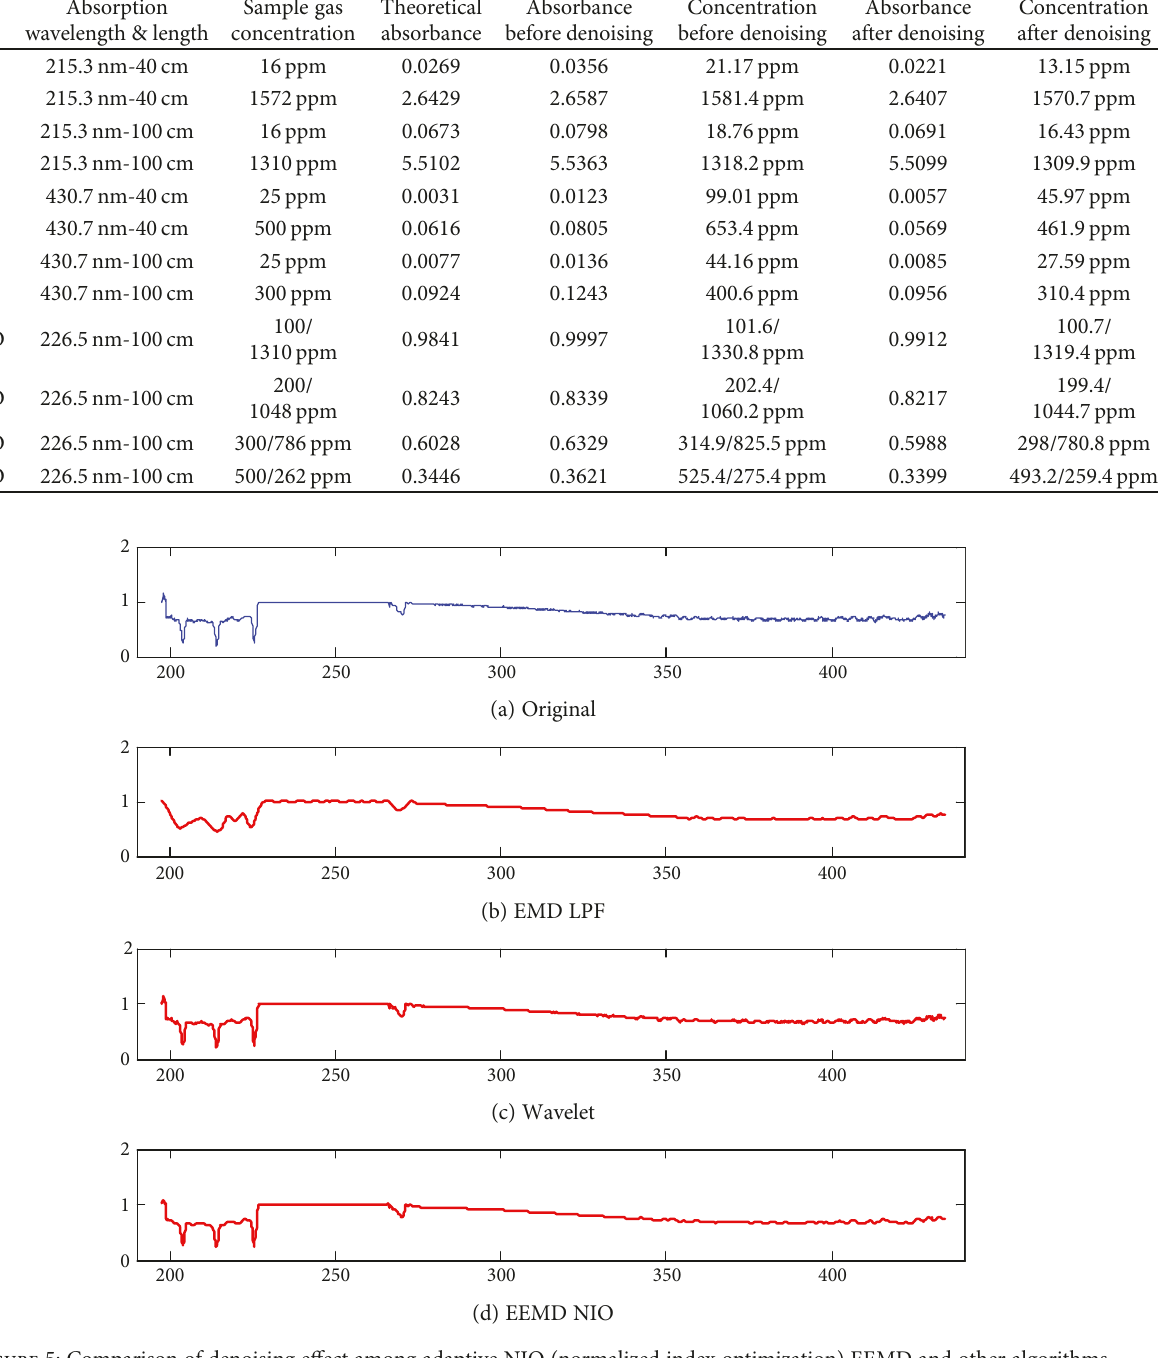
Figure 5: Comparison of denoising e ff ect among adaptive NIO (normalized index optimization) EEMD and other algorithms.